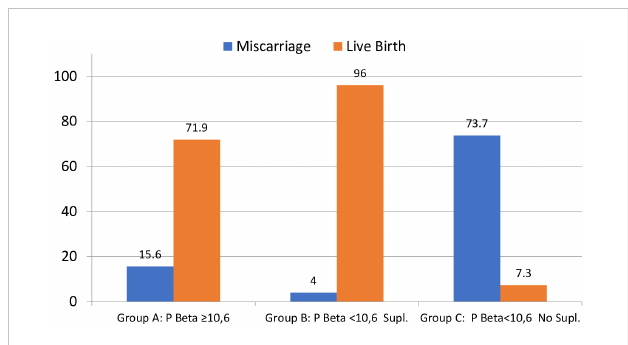
FIGURE 3 Percentage of miscarriage and live birth per positive hCG ( ≥ 10 IU). Note that groups A and C do not reach 100% because group A has three VIG (>12 weeks) and 1 still birth (malformation) and group C has two VIG (>12 weeks). VIG, voluntary interruption of gestation; hCG, human chorionic gonadotropin. Miscarriage p < 0.0001; live birth p < 0.0001.